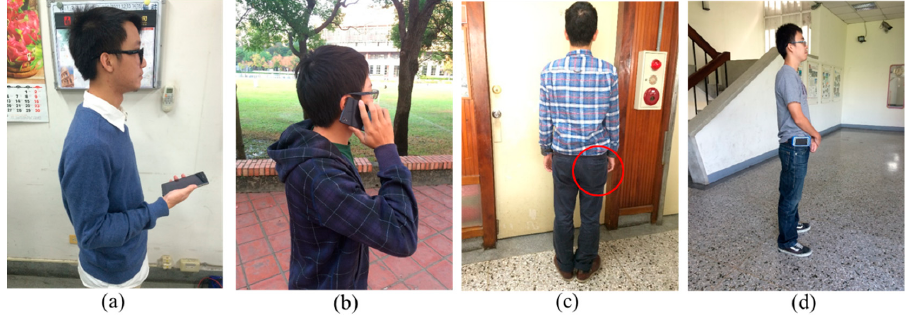
Figure 7. Experimental data collection and device placement. ( a ) Smartphone held in the hand (reading); ( b ) Smartphone close to the ear; ( c ) Smartphone in the pocket; ( d ) Smartphone on the belt.